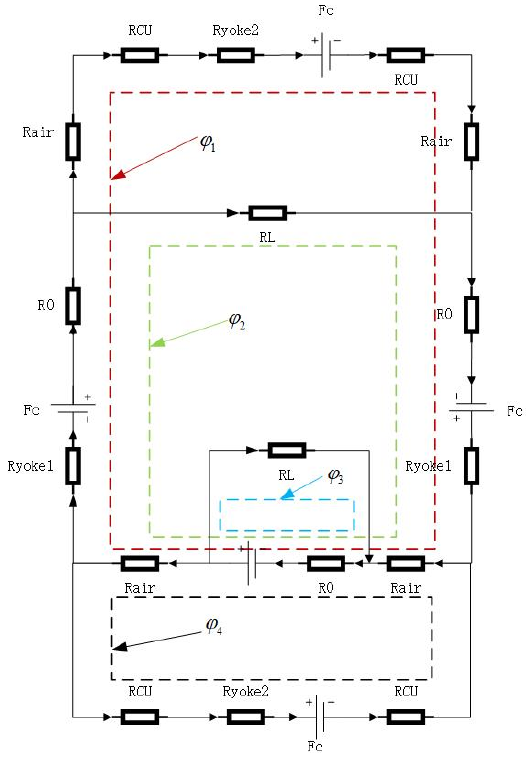
Figure 4. Magnetic reluctance circuit of Halbach permanent magnet cell.